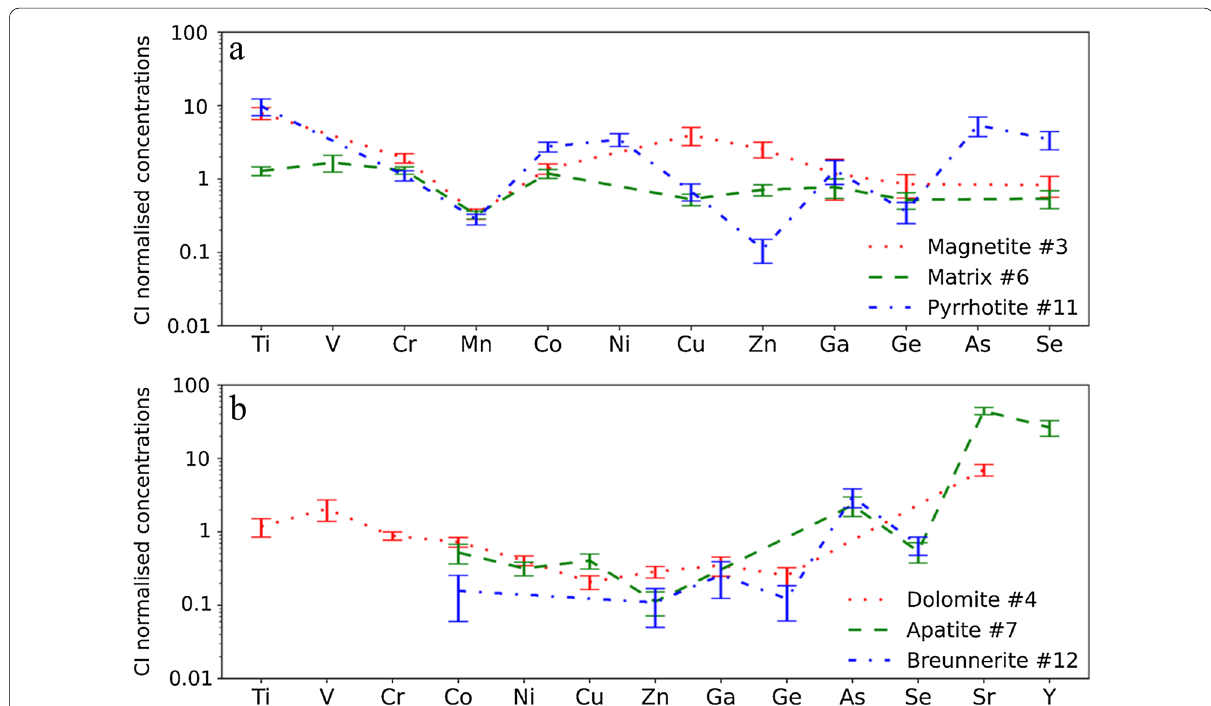
Fig. 9 a CI‑normalised concentration values of trace elements in magnetite #3, matrix #6 and pyrrhotite #11. b CI‑normalised concentration values of trace elements in dolomite #4, apatite #7 and breunnerite #12. CI normalisation is performed with CI chondrite composition data from Lodders, 2010. Error bars are 1